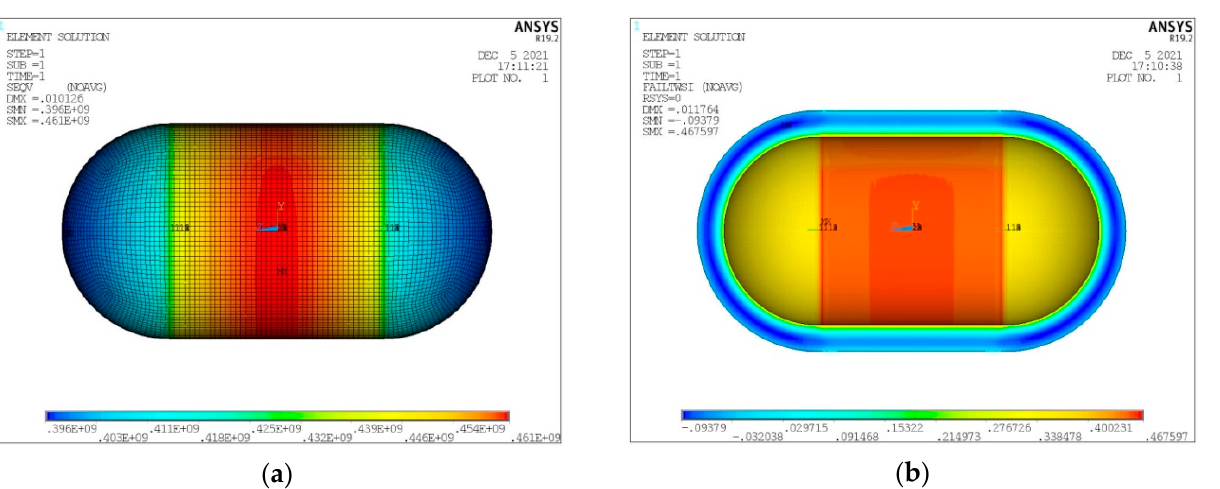
Figure 11. Distribution of ( a ) Von Mises stress on the inner aluminum shell and ( b ) Tsai–Wu index on the insulating material.